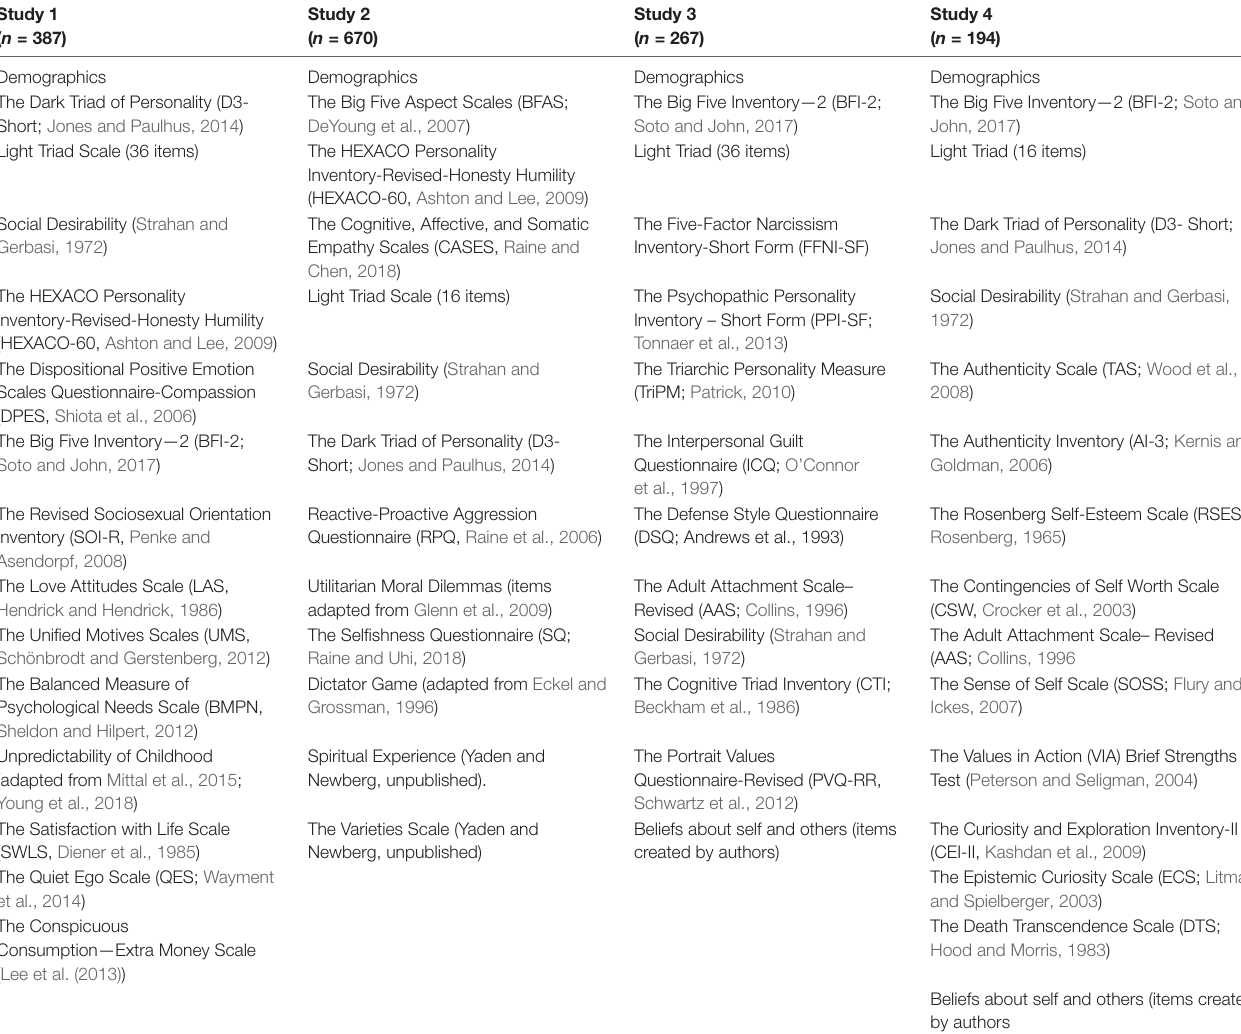
TABLE 1 | Order of presentation of tests for each